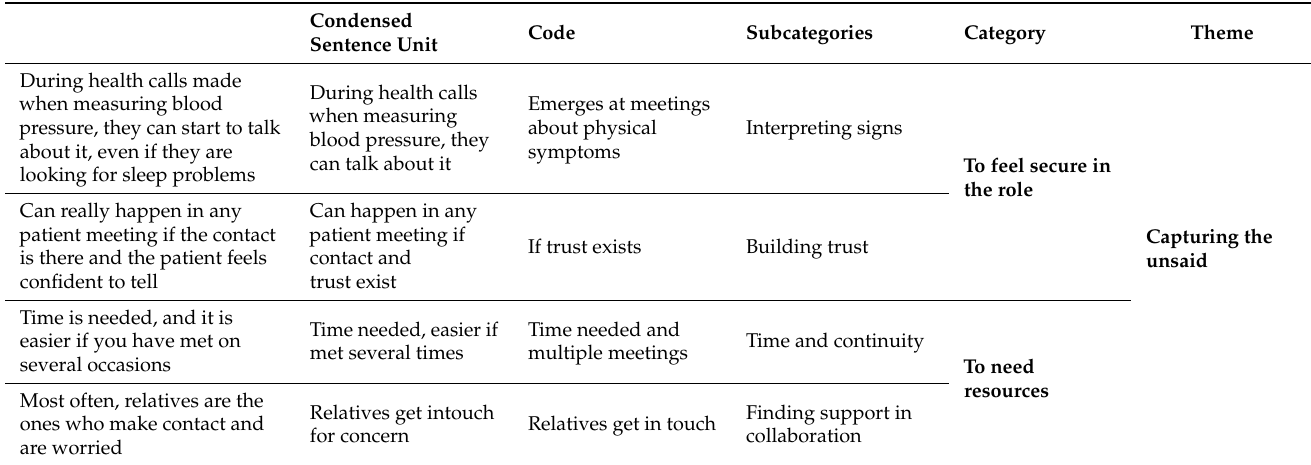
Table 3. Examples of steps in the